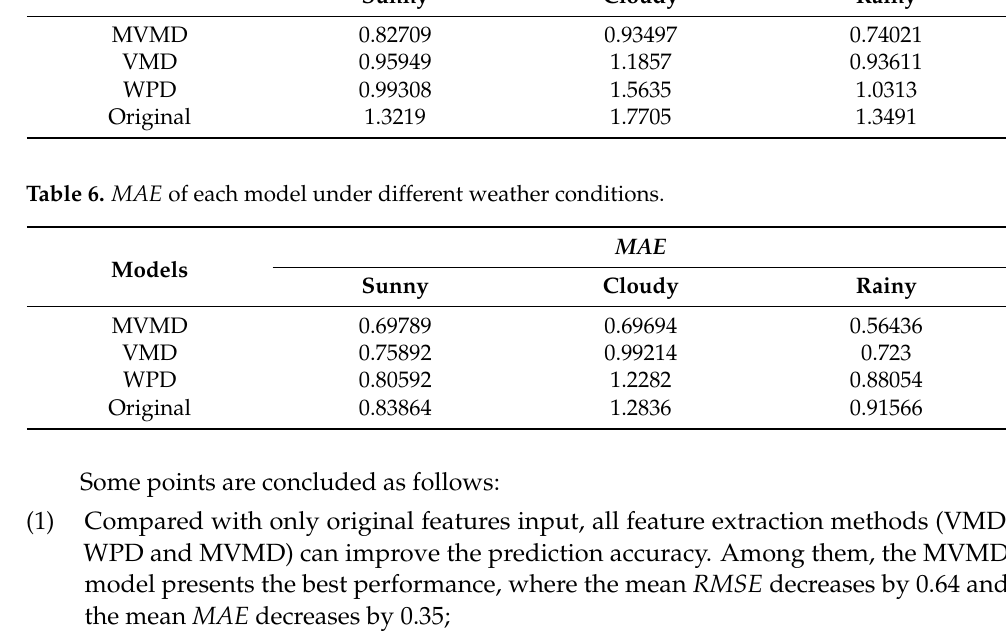
Table 5. RMSE of each model under different weather conditions. Models